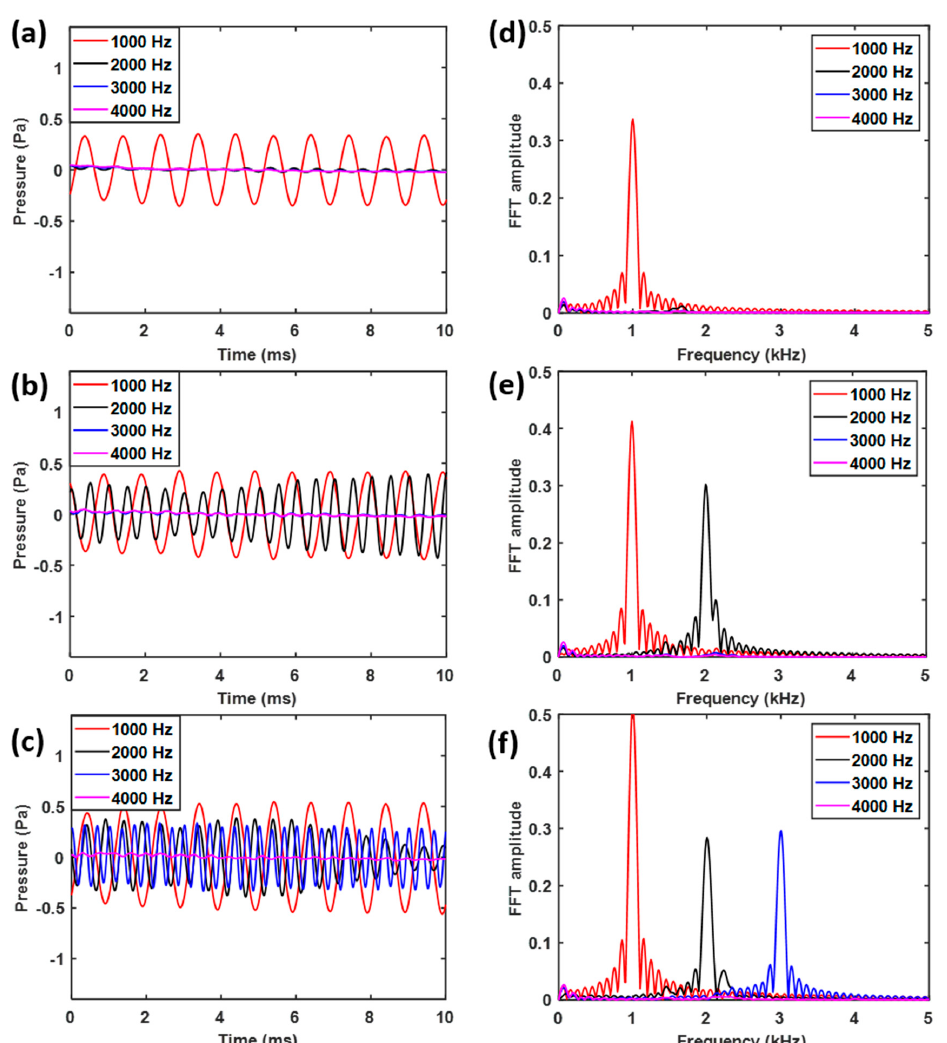
Figure 4. Pressure level at the ( a ) 37th ( b ) 17th and ( c ) 7th cylinders, and the corresponding Fourier spectrum of the pressure level at the ( d ) 37th ( e ) 17th and ( f ) 7th cylinders.